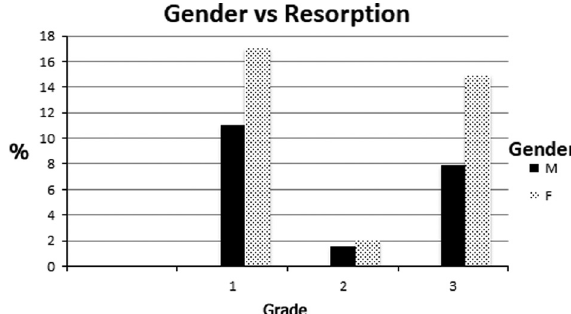
Figure 8. Site of impaction correlated to the severity of